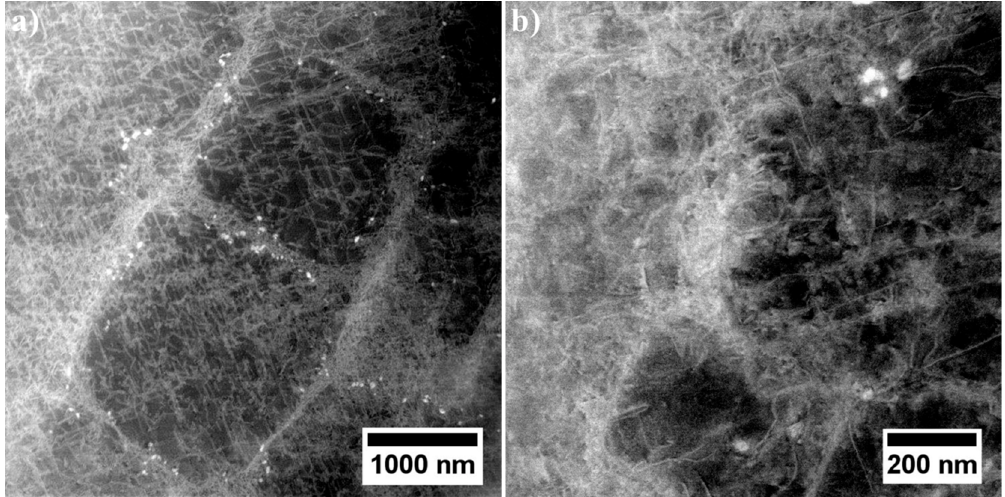
Figure 10. Microstructure of secondary γ ' with nano-precipitates at the γ / γ ' interface: a ) cubic-shaped γ ' precipitates; b ) complex-shaped γ ' precipitate, STEM-HAADF.